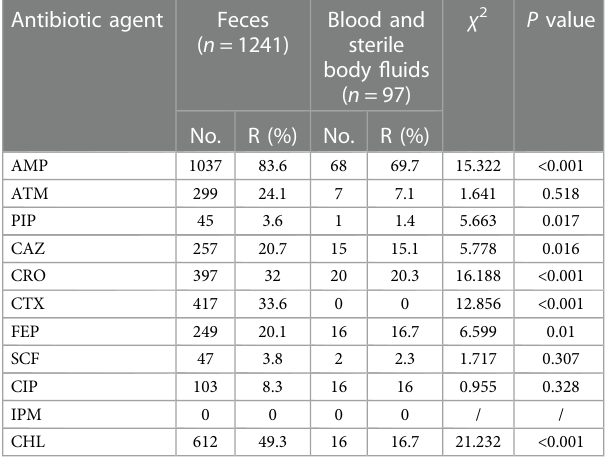
TABLE 4 Analysis of antimicrobial resistance rate of Salmonella isolates from blood and feces. Antibiotic agent